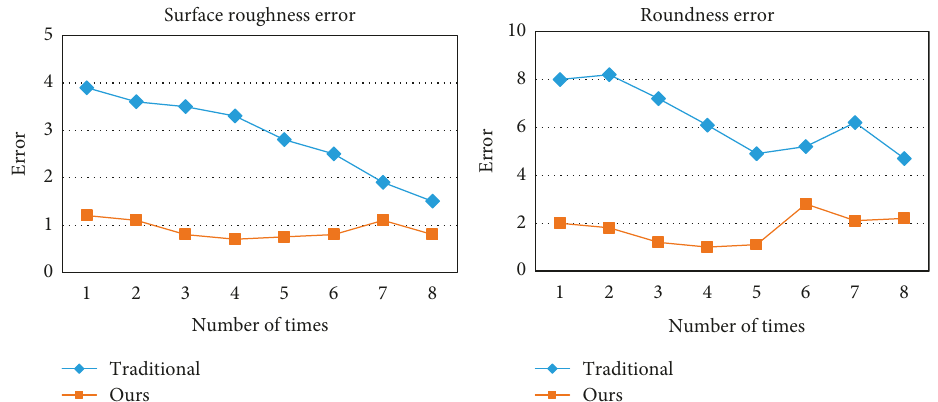
Figure 6: Comparison of application effect between RBF neural network control and traditional method in NC machining of